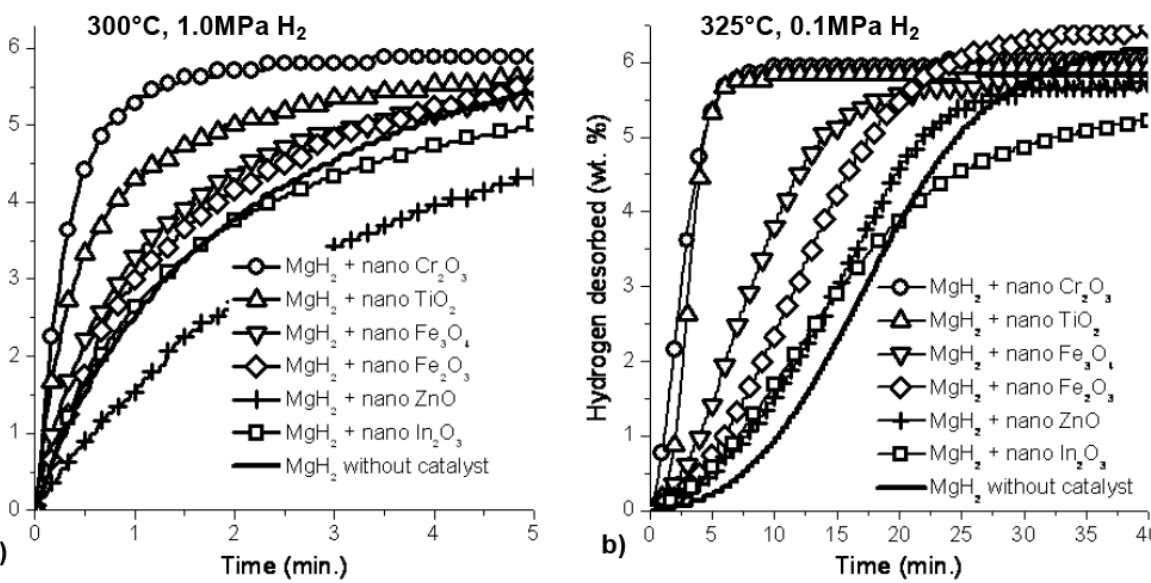
ball milled with 2